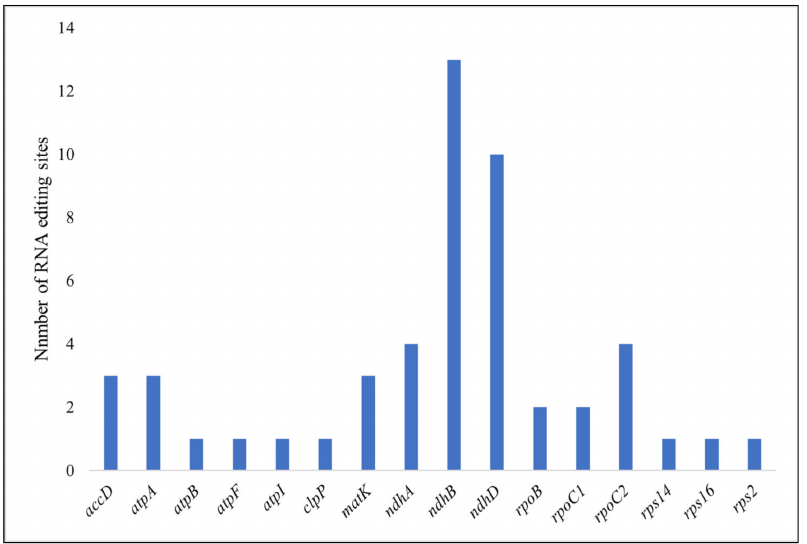
Figure 5. Predicted RNA editing site in the coding genes of the Ficus populifolia